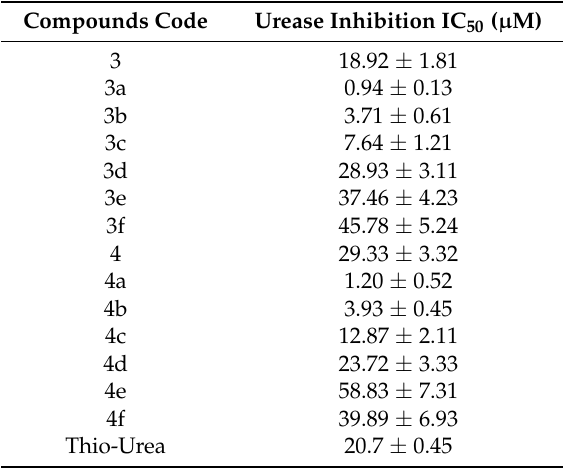
Table 3. The inhibitory effect of synthesized compounds toward urease.